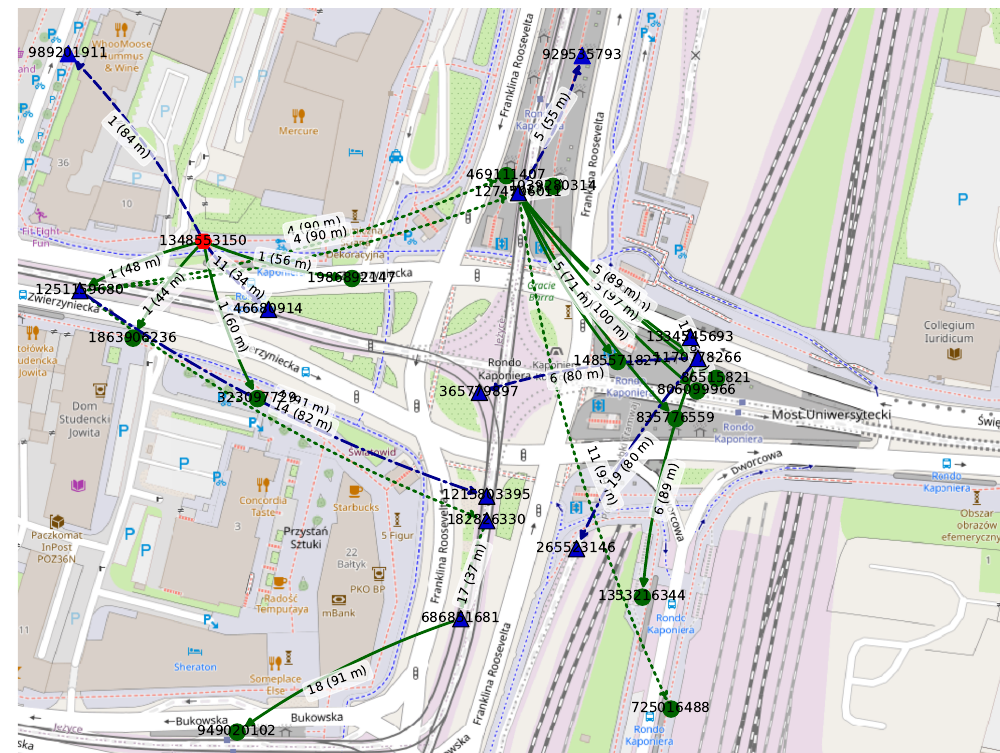
Figure 12. Opportunistic localized class-based multicast